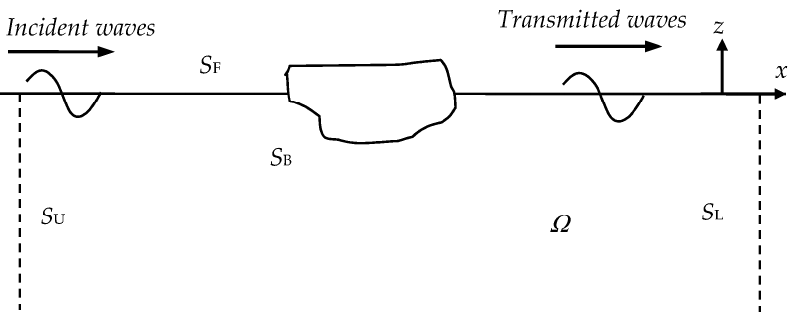
Figure 1. Computation domain of the problem.